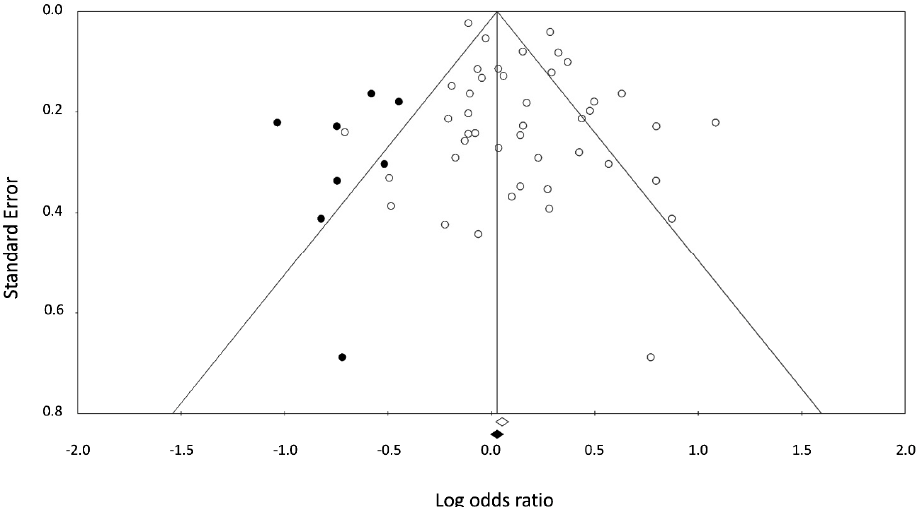
Figure 4. Funnel plot of standard error by log odds ratio with observed (white dot) and imputed (black dot) studies using the Trim and Fill method. Two diagonal lines represent 95% confidence limits.